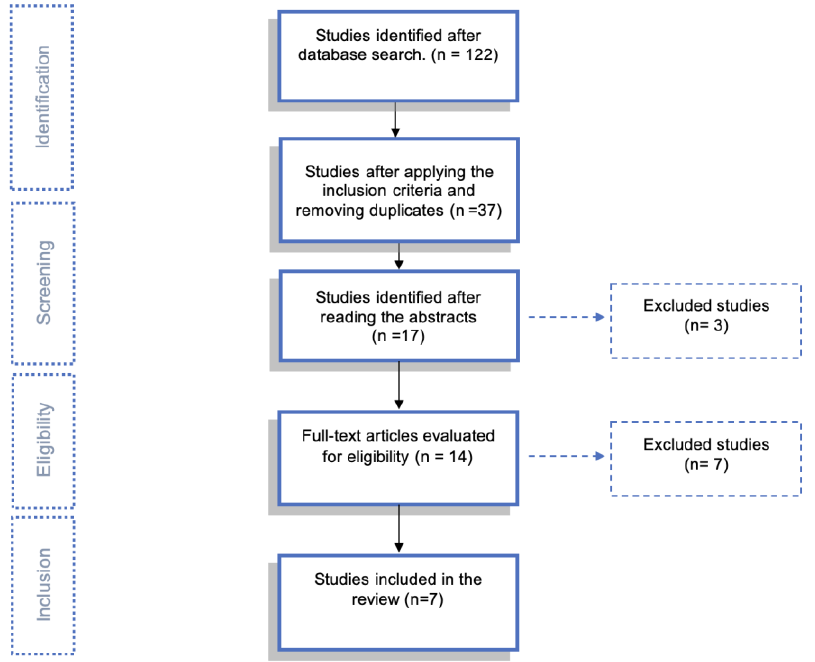
Figure 1. PRISMA Figure 1 . PRISMA flowchart.